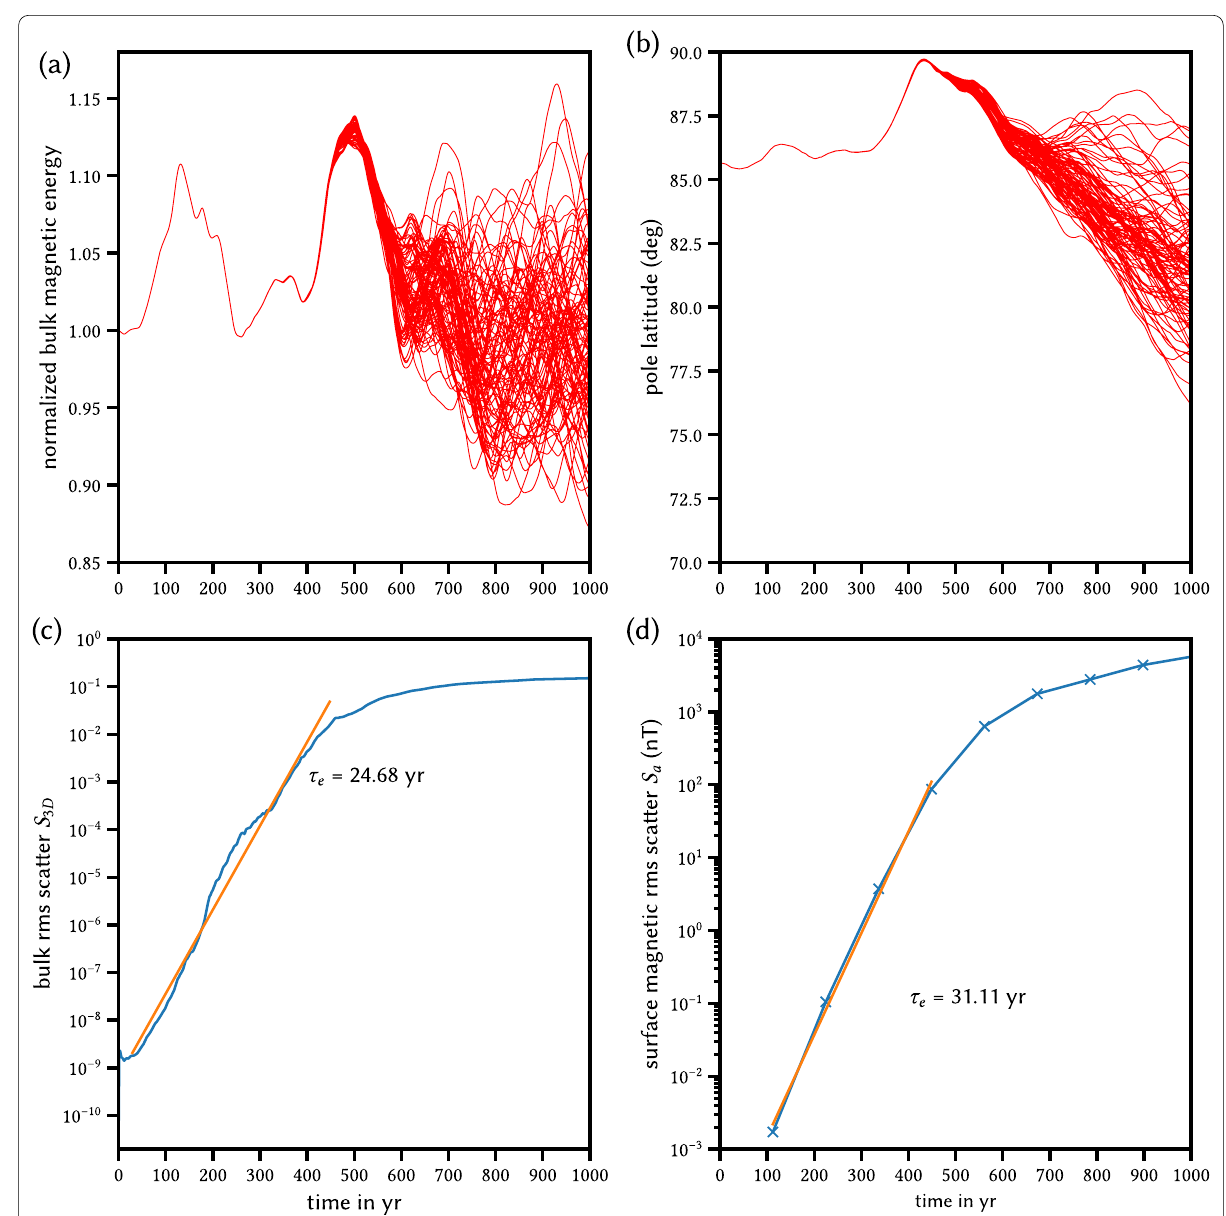
Fig. 3 Deterministic chaos for the coupled Earth dynamo model of Aubert et al. (2013). 100 dynamo models are integrated forward in time, starting from close initial conditions. Each initial condition is defined by the same, well-equilibrated dynamo state whose axial dipole is slightly perturbed by a normal perturbation of relative amplitude 10 − 8 . a bulk magnetic energy versus time, normalized by its value at t ensemble. b latitude of geomagnetic North at Earth’s surface, for the 100 members of the ensemble. c 3D scatter S 3 D versus time. τ e is the e -folding time. d scatter of simulated magnetic fields S a at Earth’s surface. Ensemble integration and on-the-fly diagnostics obtained using the parody_ pdaf implementation (Fournier et al. 2013). See text for